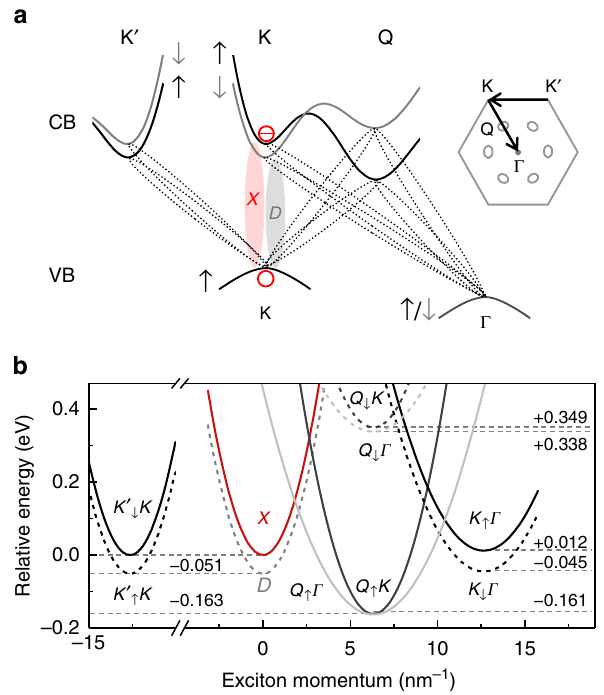
Fig. 2 Excitons in bilayer WSe 2 . a Schematic single-particle band diagram of the conduction and the valence bands of bilayer WSe 2 along high- symmetry lines of the hexagonal Brillouin zone shown on the right. Zero- momentum spin-bright ( X ) and spin-dark ( D ) excitons are formed in the K valley by electrons from spin-up and spin-down conduction sub-bands indicated in black and gray, respectively, paired with a spin-up valence band empty state. Momentum-indirect excitons with electrons and unoccupied states in dissimilar valleys are indicated by dashed ellipses. b Calculated dispersions of lowest-energy exciton manifolds in bilayer WSe 2 with energy minima given in eV with respect to the bright exciton